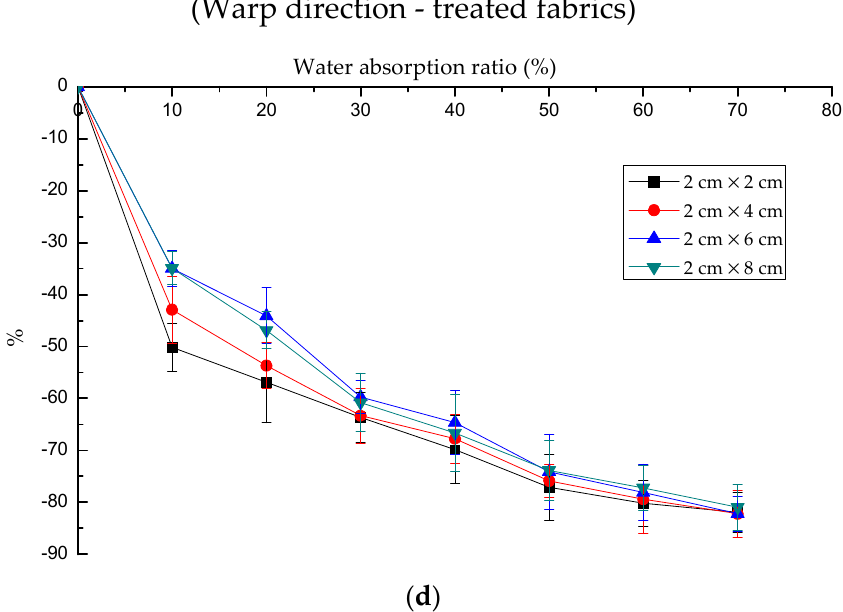
Figure 6. The percentage of the decline of log (electrical resistance) for each sample in the warp and weft directions when comparing the samples under the different water absorption. The declining trend of untreated fabrics is more stable when compared with that untreated fabric. ( a ) the percentage of log r for untreated fabric at weft direction; ( b ) the percentage of log r for untreated fabric at warp direction; ( c ) the percentage of log r for treated fabric at weft direction; ( d ) the percentage of log r for treated fabric at warp direction.